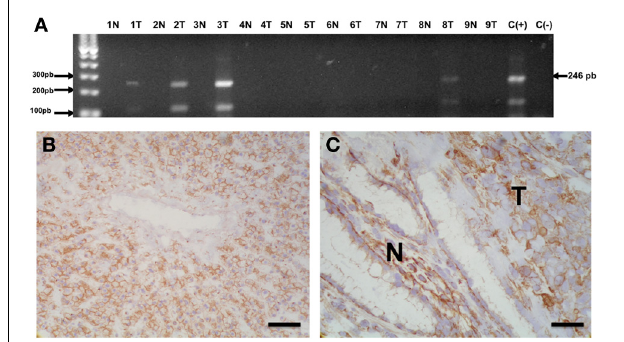
FIGURE 1 | Methylation of Cx32 promoter region in human gastric adenocarcinomas. (A) Agarose gel showing the results from methylation specific PCR of sodium bisulphite-modified DNA extracted from 9 frozen gastric adenocarcinomas (1T-9T) and non-tumor tissue from the same subjects (1N-9N). In 4 cases, a 246 bp band corresponding to the methylated sequence in the Cx32 promoter region was identified. C( + ) = Positive control sample of methylated DNA; C( − ) = Negative control lacking template DNA. (B,C) Microphotographs showing Cx32 immunostaining in morphologically normal human liver (B) and non-tumor (N)/tumor (T) interface from one gastric adenocarcinoma sample (C) . Liver was used as positive control and showed homogenous and intense membranous-like staining. Cx32 immunoreactivity was also detected in the normal foveolar gastric epithelium (N) and in malignant epithelial carcinoma cells (T). The previously reported (Sánchez et al., 2009) monoclonal anti-Cx32 antibody clone 72F (dilution 1:1500, overnight incubation) was used to stain frozen sections. Preparations were then counterstained with hematoxilin. Bar = 100 μ